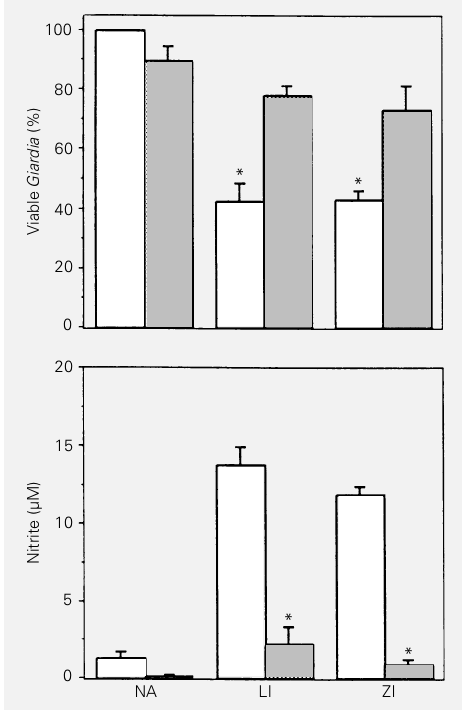
Figure 1 - Effect of macrophage activation on Giardia trophozoite killing (upper panel) and nitrite production (lower panel). Murine peritoneal macrophages were activated with IFN- g (20 U/ml) plus LPS (100 ng/ml; LI) or with IFN- g plus zymosan (80 (cid:181)g/ml; ZI). Open and shaded bars are experiments performed in the absence or in the presence of L- NIO (200 (cid:181)M),